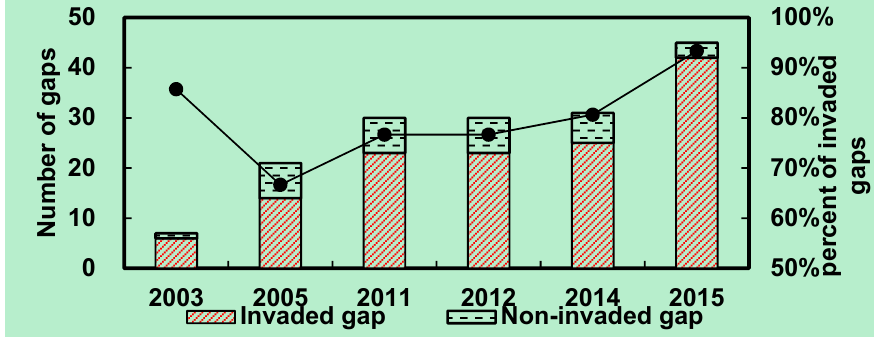
Figure 6. The invasion of S. alterniflora in mangrove forests.